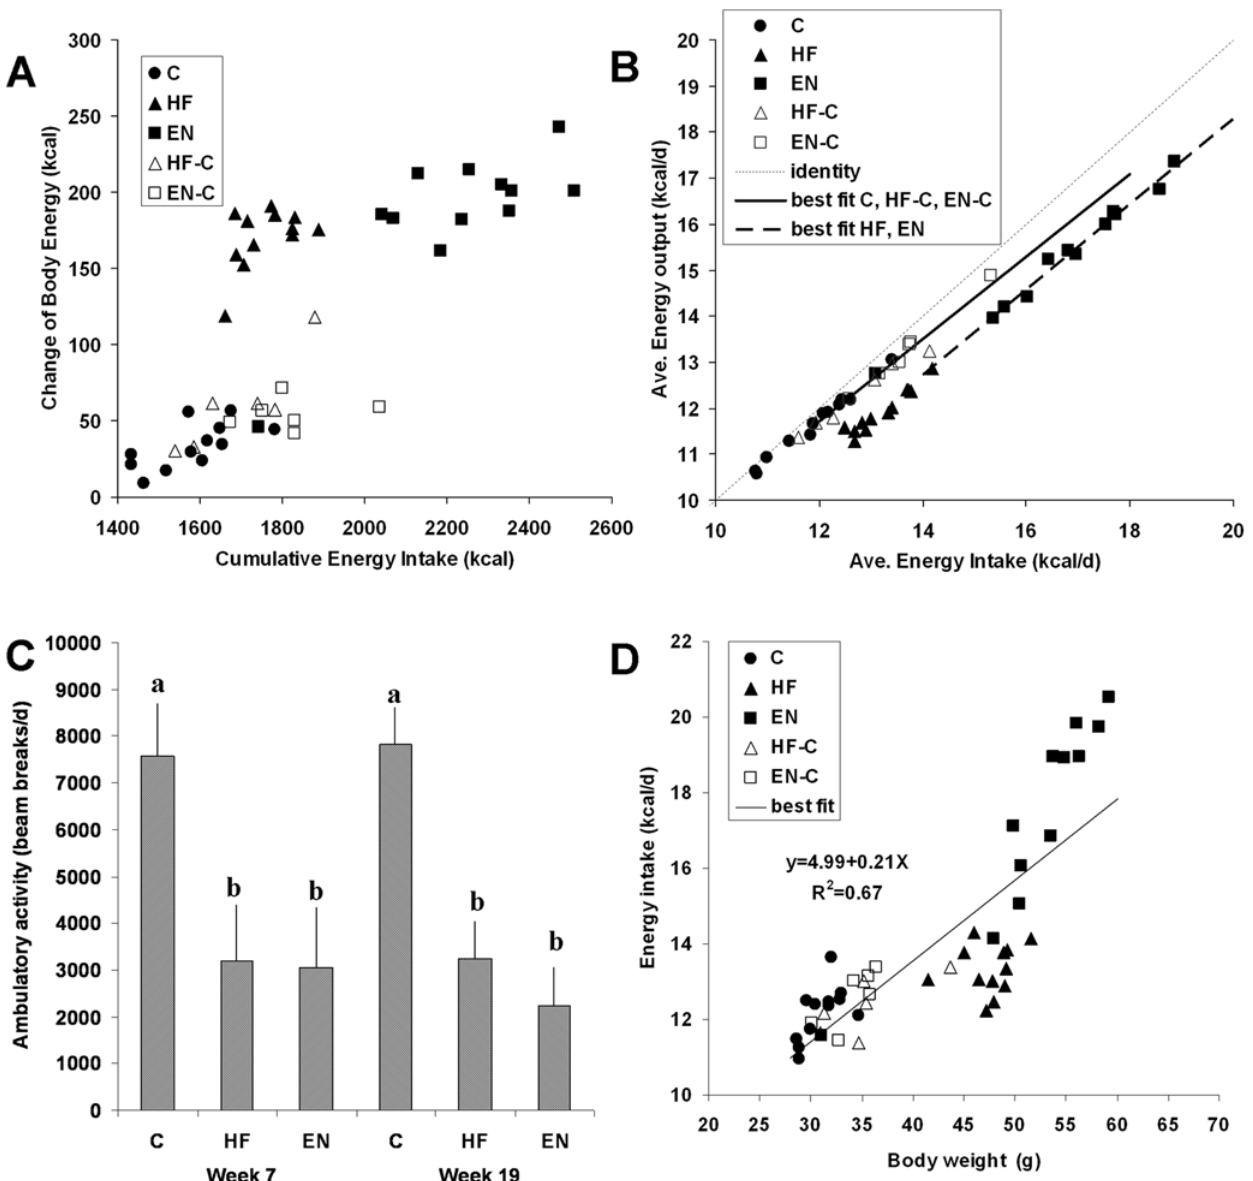
Figure 4. Energy intake, energy output, change of body energy, and ambulatory activity. Body energy changes versus cumulative energy intake over the 19 week experiment (Panel A) and the calculated 19 week average energy output rate versus average energy intake rate (Panel B). The data points indicate individual mice from the 5 diet groups: chow diet (C), high fat diet (HF), high fat diet plus Ensure H (EN), high fat diet for 7 wk followed by a switch to chow (HF-C), and high fat diet plus Ensure H for 7 wk followed by a switch to chow (EN-C). In panel B, the dotted line is the line of identity indicating average energy balance. The solid line is the best-fit regression line for the C, HF-C, and EN-C groups (slope=0.90 6 0.03, intercept=0.97 6 0.44 kcal/d, R2=0.98) and the dashed line is the best-fit regression line for the HF and EN groups (slope=0.92 6 0.02, intercept= 2 0.21 6 0.28 kcal/d, R2=0.99). C) The average ambulatory activity of the mice measured at weeks 7 and 19. The bars with different letters indicate significant differences of ambulatory activity within each time period (P , 0.05). Panel D plots the energy intake rate over the last two weeks of the study as a function of the final body weight (slope=0.21 6 0.02 kcal/g/d, intercept=4.99 6 0.93 kcal/d, R2=0.67). The regression analysis was performed using the least square method and other statistical analyses were performed as in Figure